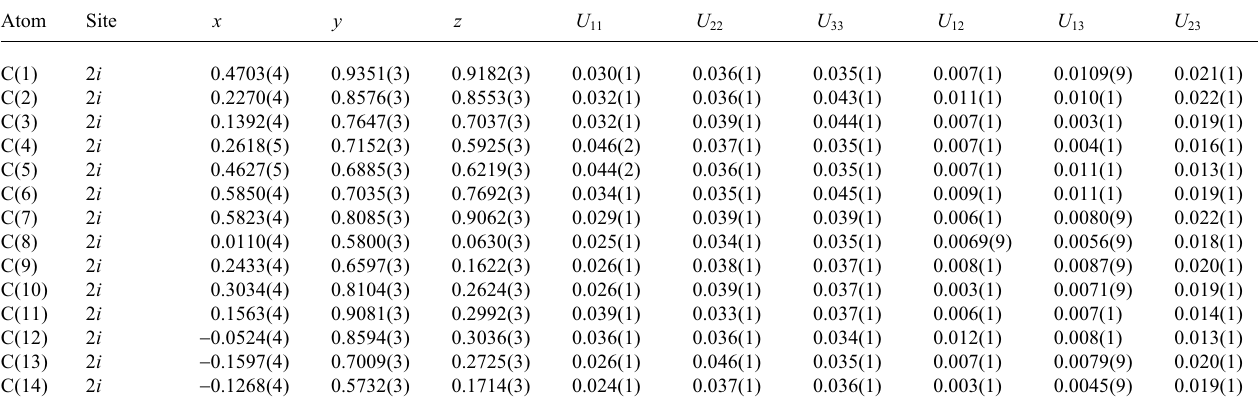
Table 3. Atomic coordinates and displacement parameters (in Å 2 )